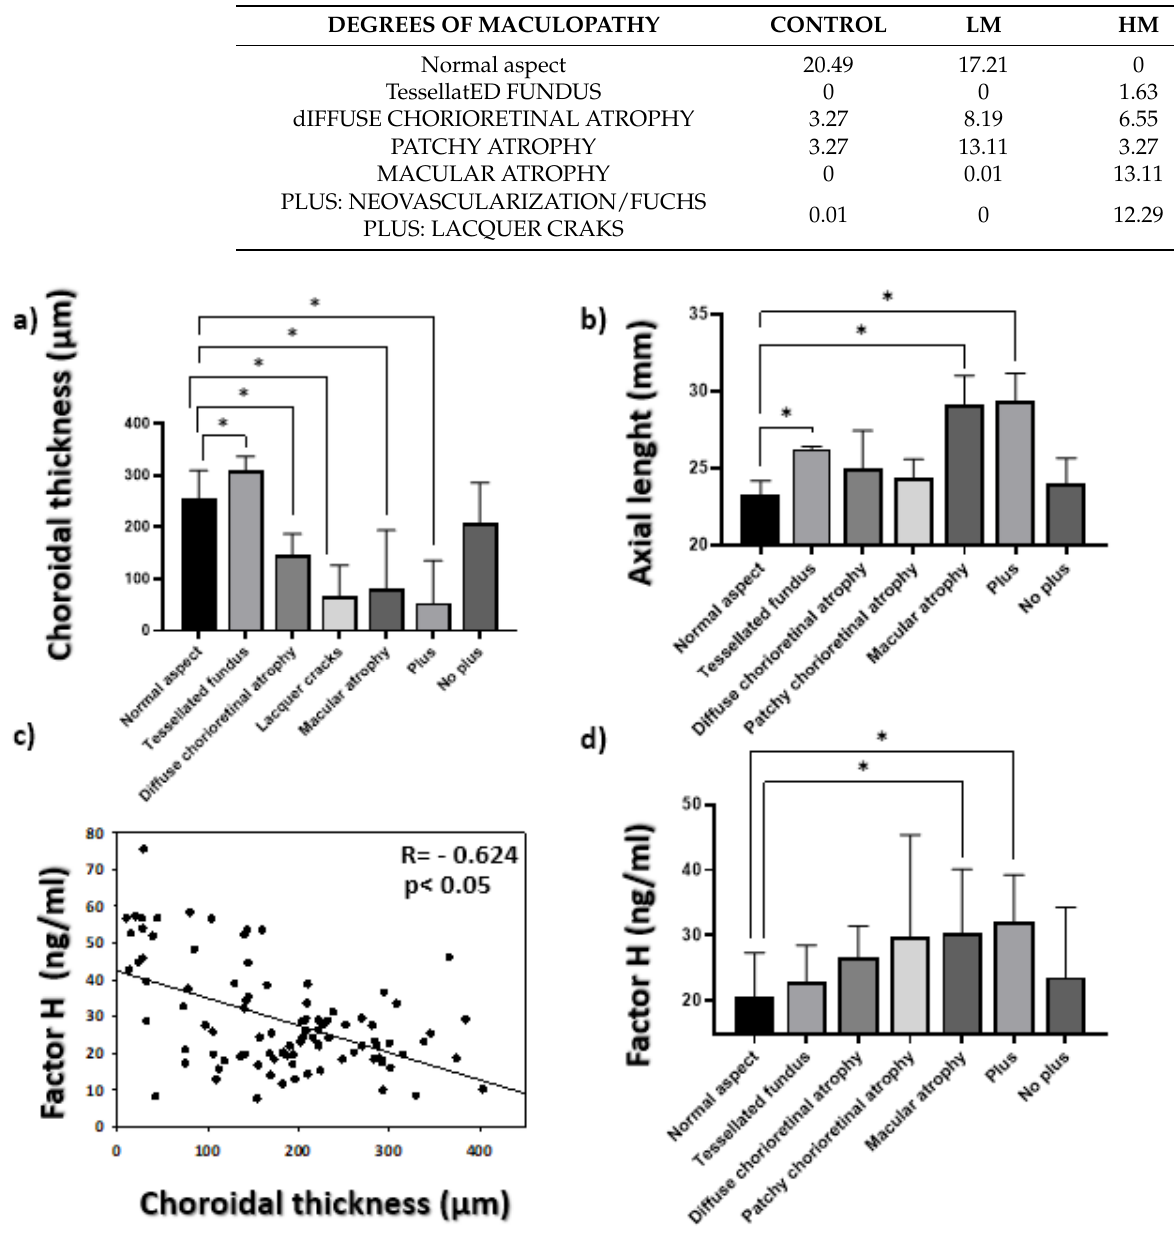
Figure 2. a) The mean concentrations of choroidal thickness in each maculopathy. Values are expressed as mean± SD; b) ( b ) Evolution of axial length and degree of maculopathy; ( c ) inverse between complement Factor H and choroid thickness Evolution of axial length and degree of maculopathy; c) inverse correlation between complement Factor H and choroid measured by OCT (R= − 0.624, p < 0.05); ( d ) mean values of correlation complement Factor H and degree of maculopathy. thickness measured by OCT (R= -0.624, p <0.05); d) mean values of complement Factor H and degree of maculopathy. The difference in means (*) was established with a significance of p ˂ 0.05. The difference in means (*) was established with a significance of p <